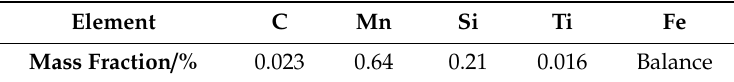
Table 1. Chemical compositions.